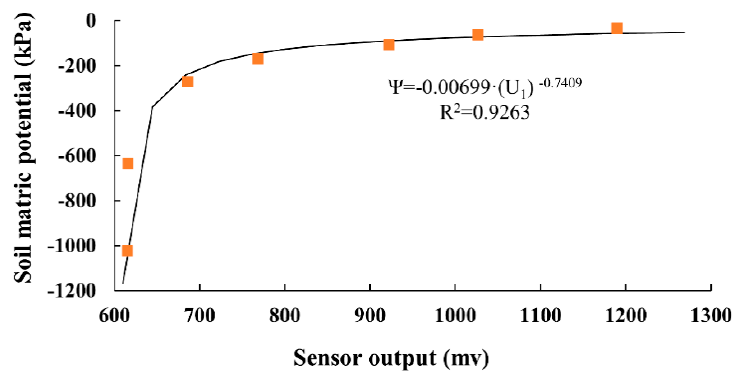
Figure 6. Curve between sensor output and soil matric potential.